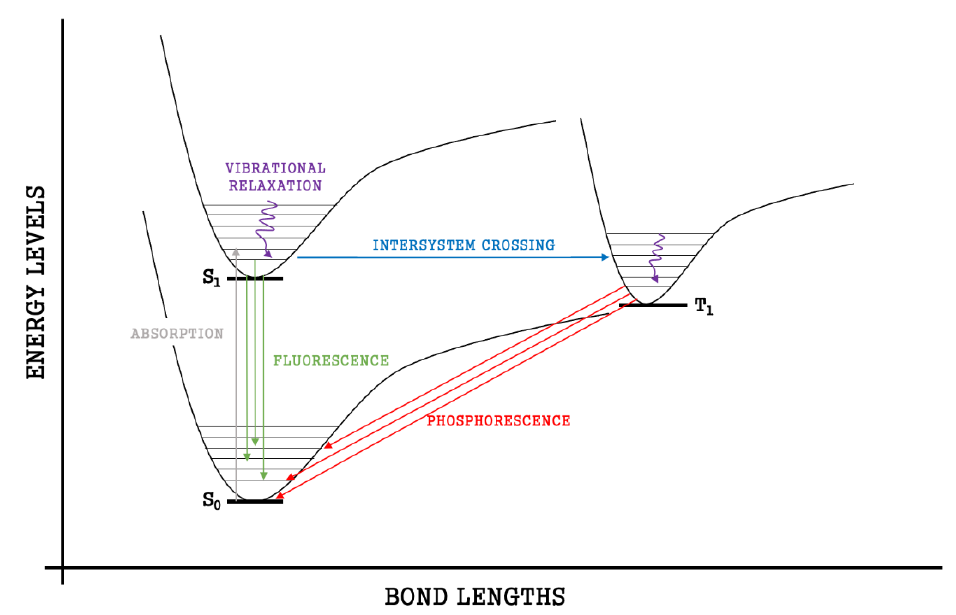
Figure 23. Difference in energy states show how the S 0 , S 1 , and T 1 states create the molecular dy- namic curves.